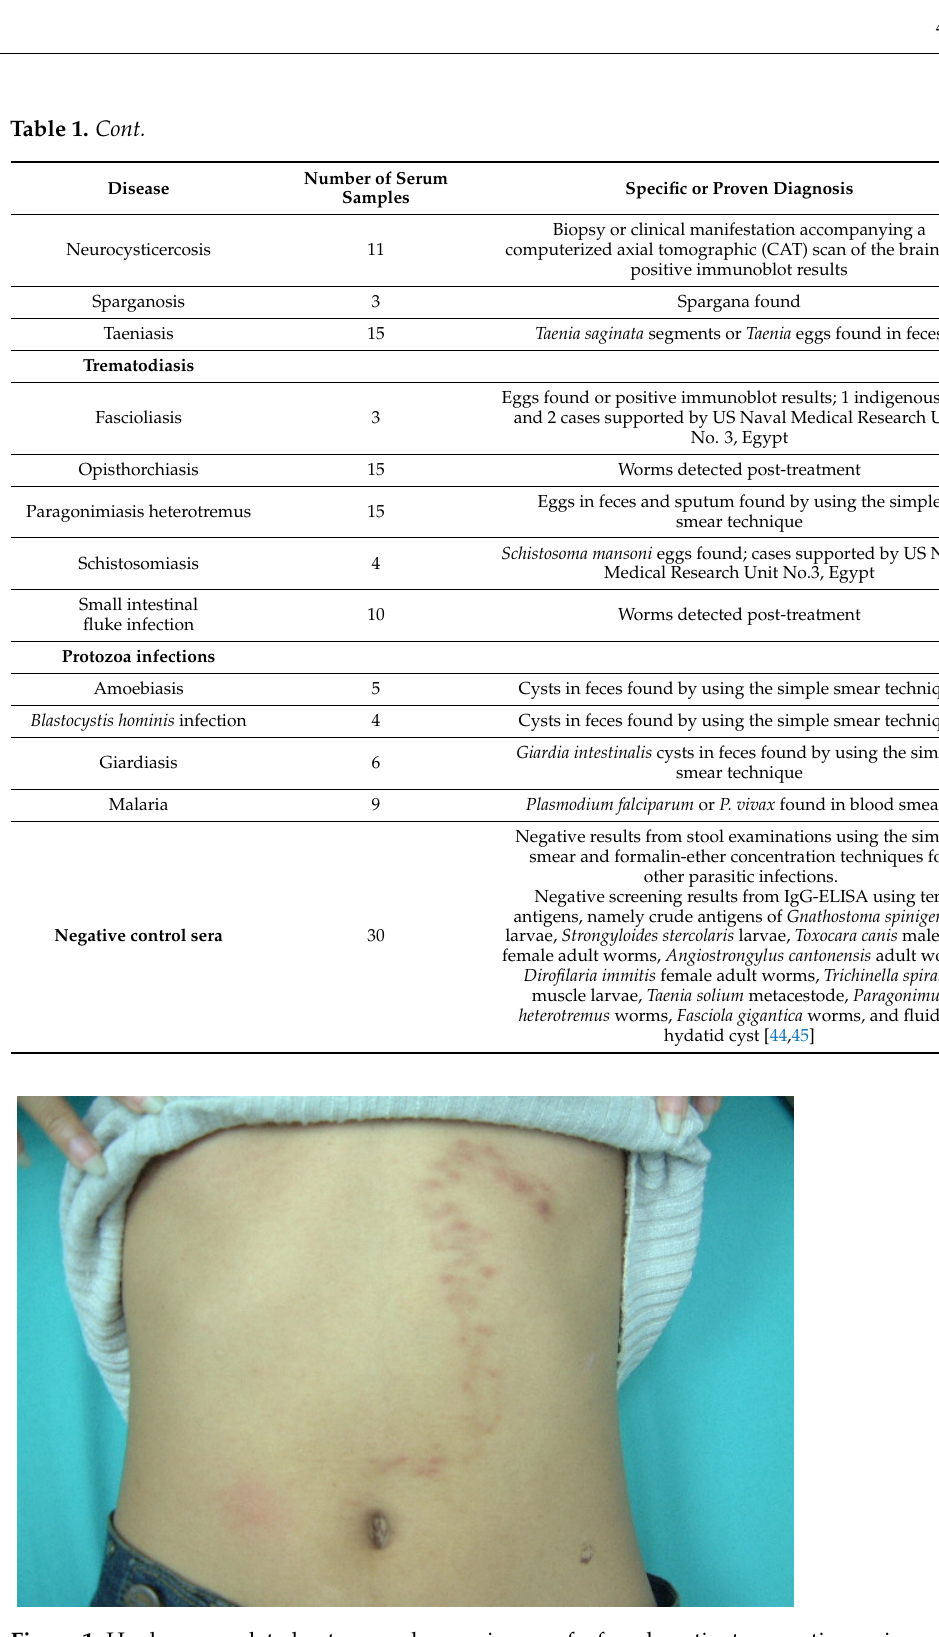
Figure 1. Hookworm-related cutaneous larva migrans of a female patient presenting a zigzag track on the abdomen.